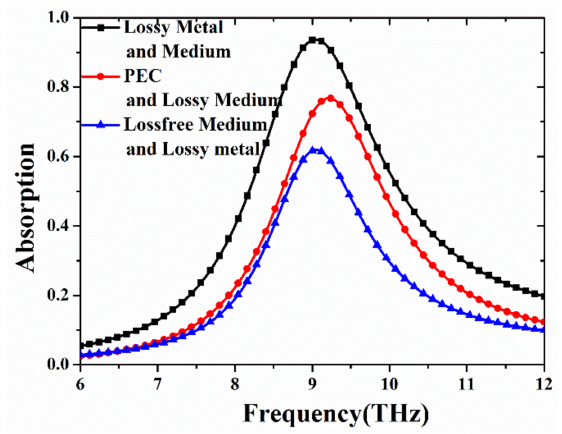
Figure 2. Dependence of absorption spectra of the proposed THz MA on different material properties of PEC (perfect electrical conductivity) and loss-free